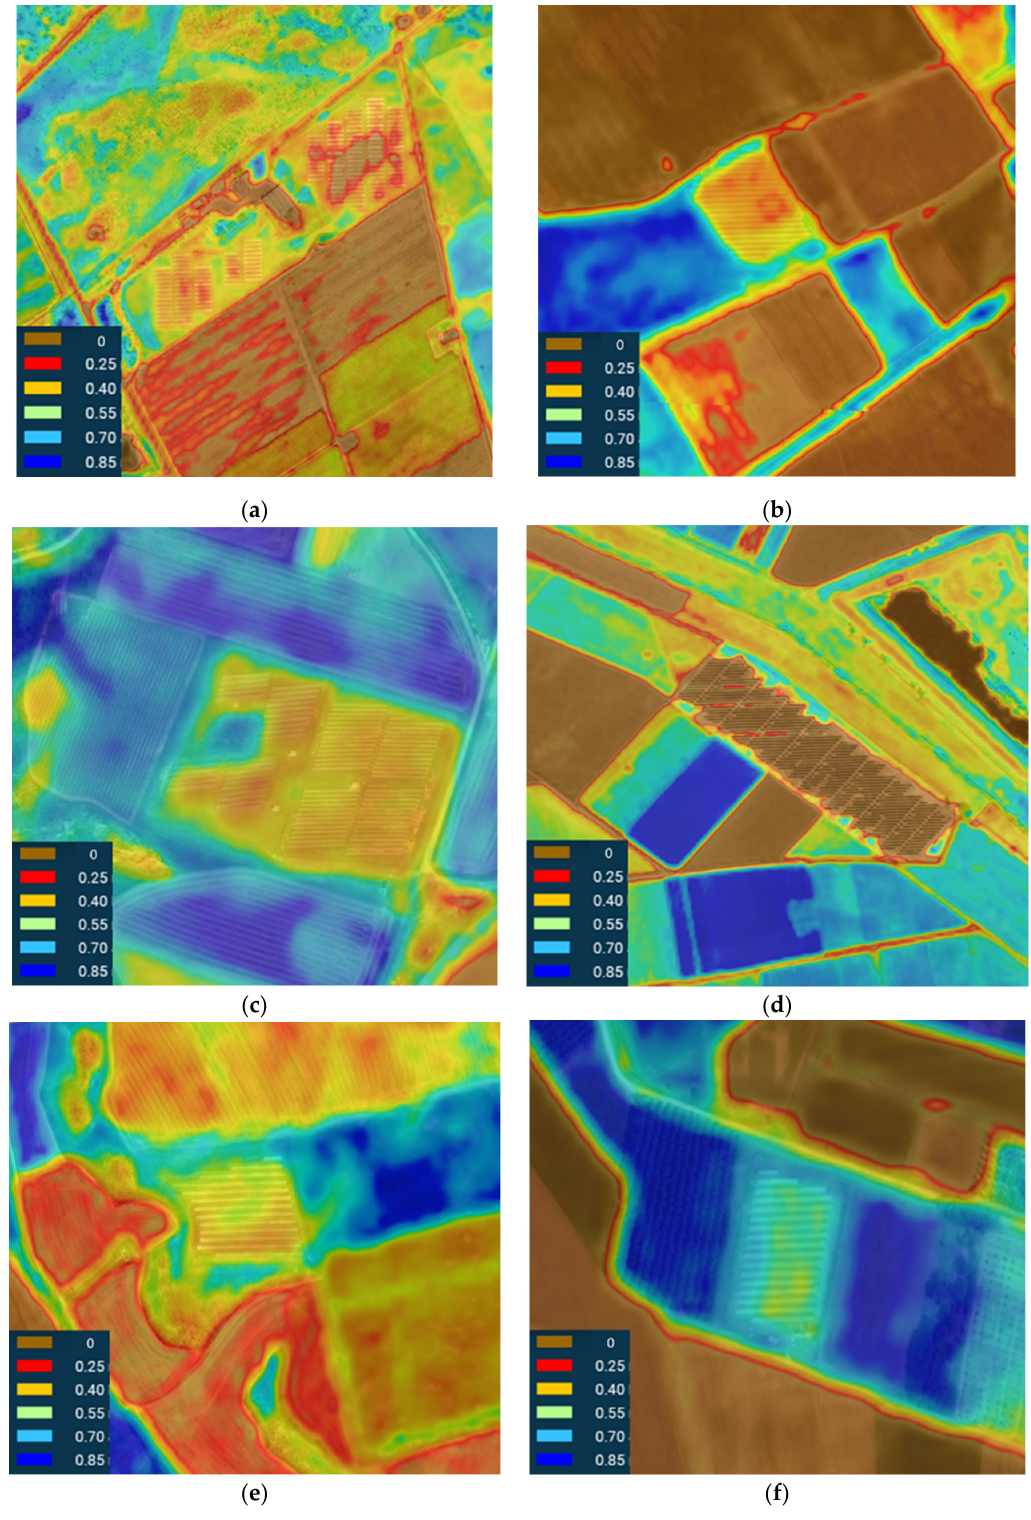
Figure 9. Graphic representation of the state of the vegetation through the NDVI for the different case studies in the month of May: ( a ) plant 1, ( b ) plant 2, ( c ) plant 3, ( d ) plant 4, ( e ) plant 5, and ( f ) plant 6.